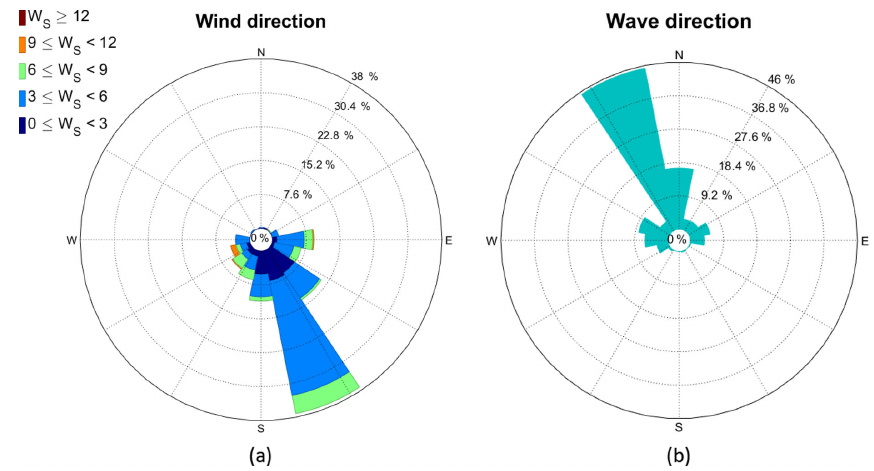
Figure A5. On the left side is the wind rose excluding the wind shadow zones at z = 40m or z = 15m depending on the measurement campaign, while on the right the peak wave direction is shown. Data correspond to the FINO1 measurement mast during the year 2010 for z = 40m and 2015–2016 for z = 15m only for wind opposing the wave